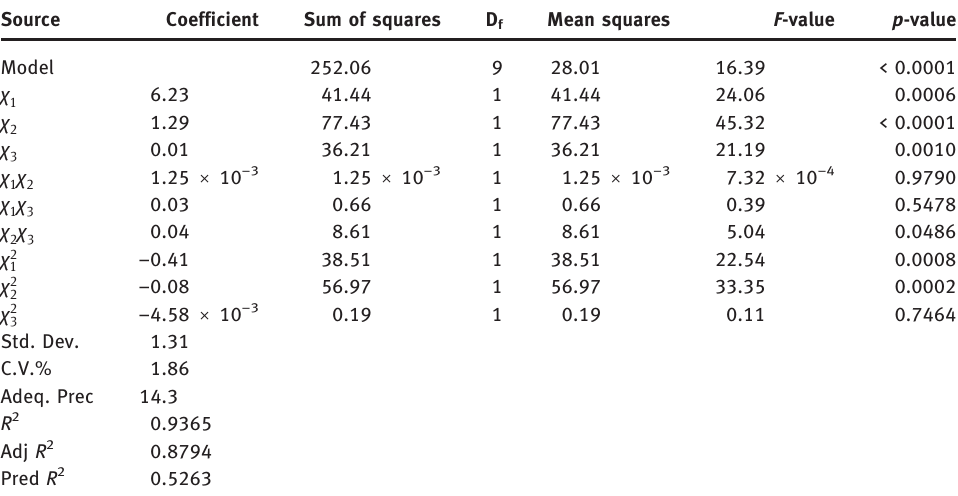
Table 3: ANOVA for the experimental results of the design. Source Coefficient Sum of squares D f Mean squares